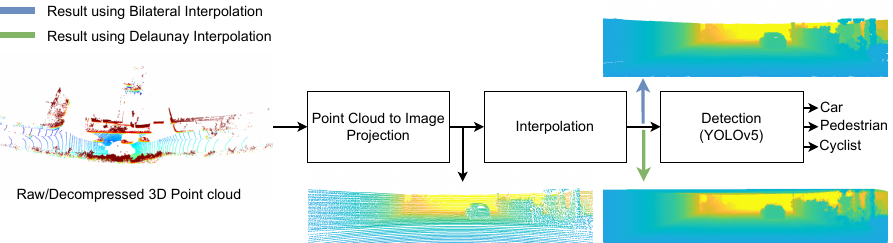
Figure 2. Pipeline of the object detection process for images projected from input 3D point clouds (raw or decompressed). Interpolation can be carried out either with Delaunay triangulation or the customized bilateral filter—the grayscale images show an example of that interpolation for either